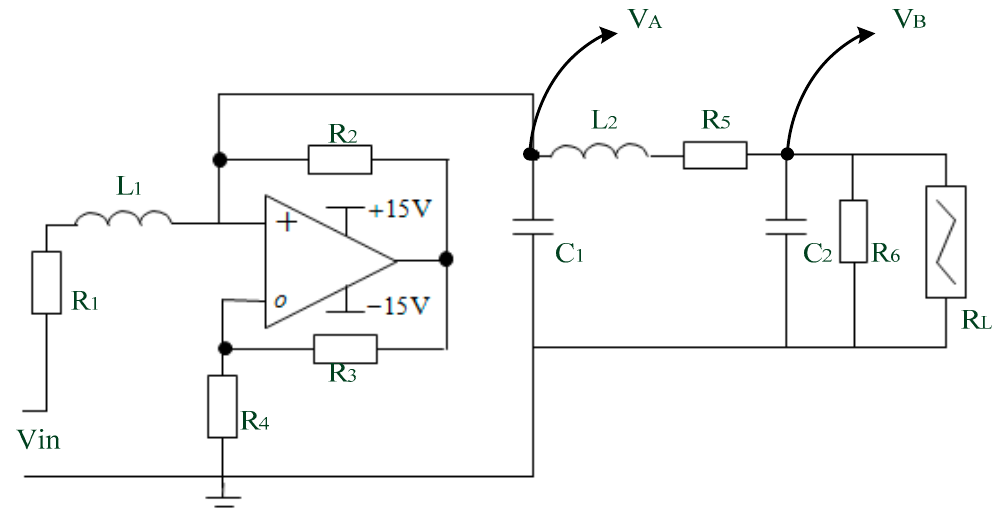
Figure 2. Diagram of the Chua’s circuit.